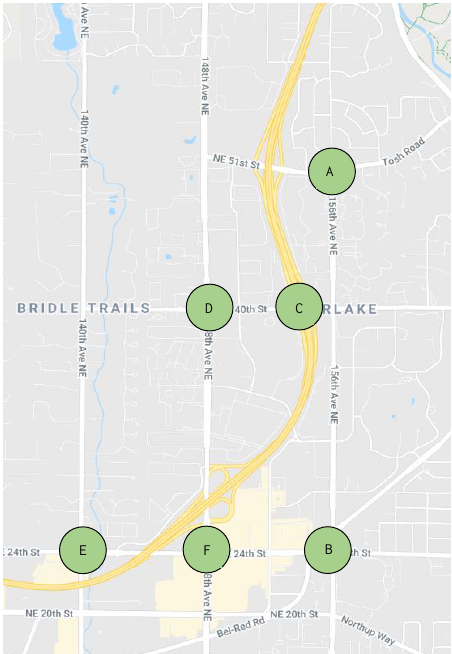
Figure 3. A section of the road network in the cities of Bellevue and Redmond in Washington, used in the simulations reference model. Hovering areas are marked as green circles.